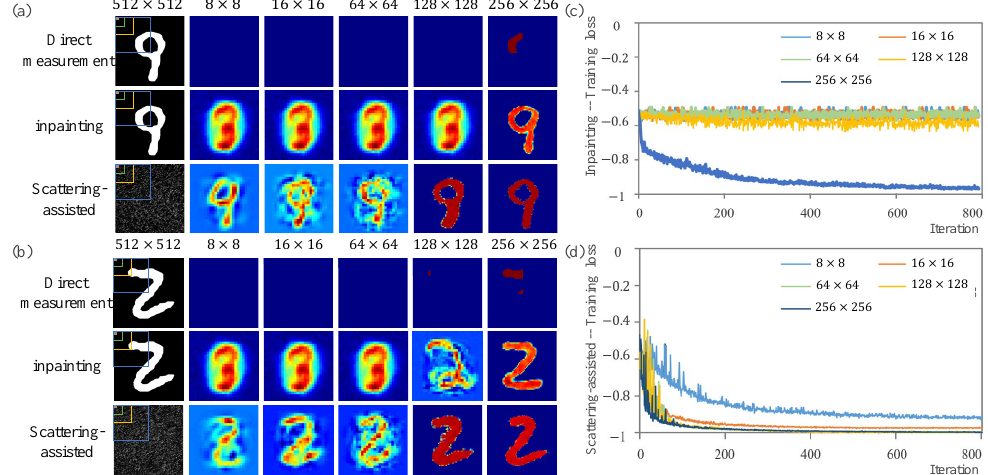
Figure 7. Results for comparative experiments. ( a ) the corresponding results of digits ’9’ with different in-line-of-sight areas; ( b ) the corresponding results of ’2’ with different in-line-of-sight areas; ( c ) the loss (NPCC between outputs and ground truths) for different block sizes with training iterations of the inpainting algorithm; ( d ) the loss for different block sizes of the proposed method.